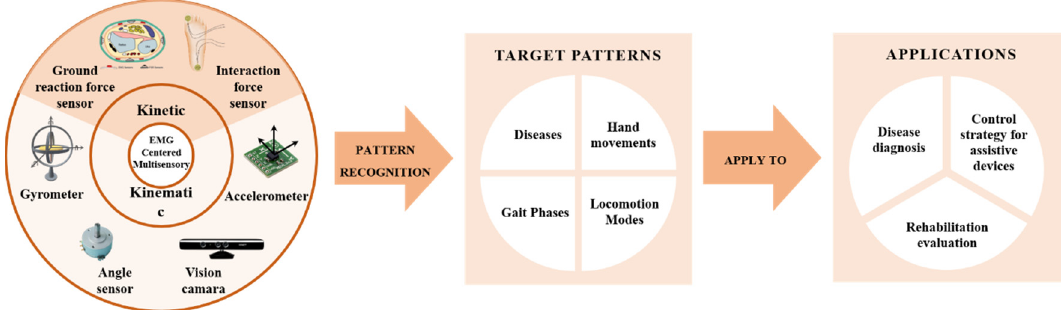
Figure 7. EMG-centered multisensory strategies and sensing blocks.